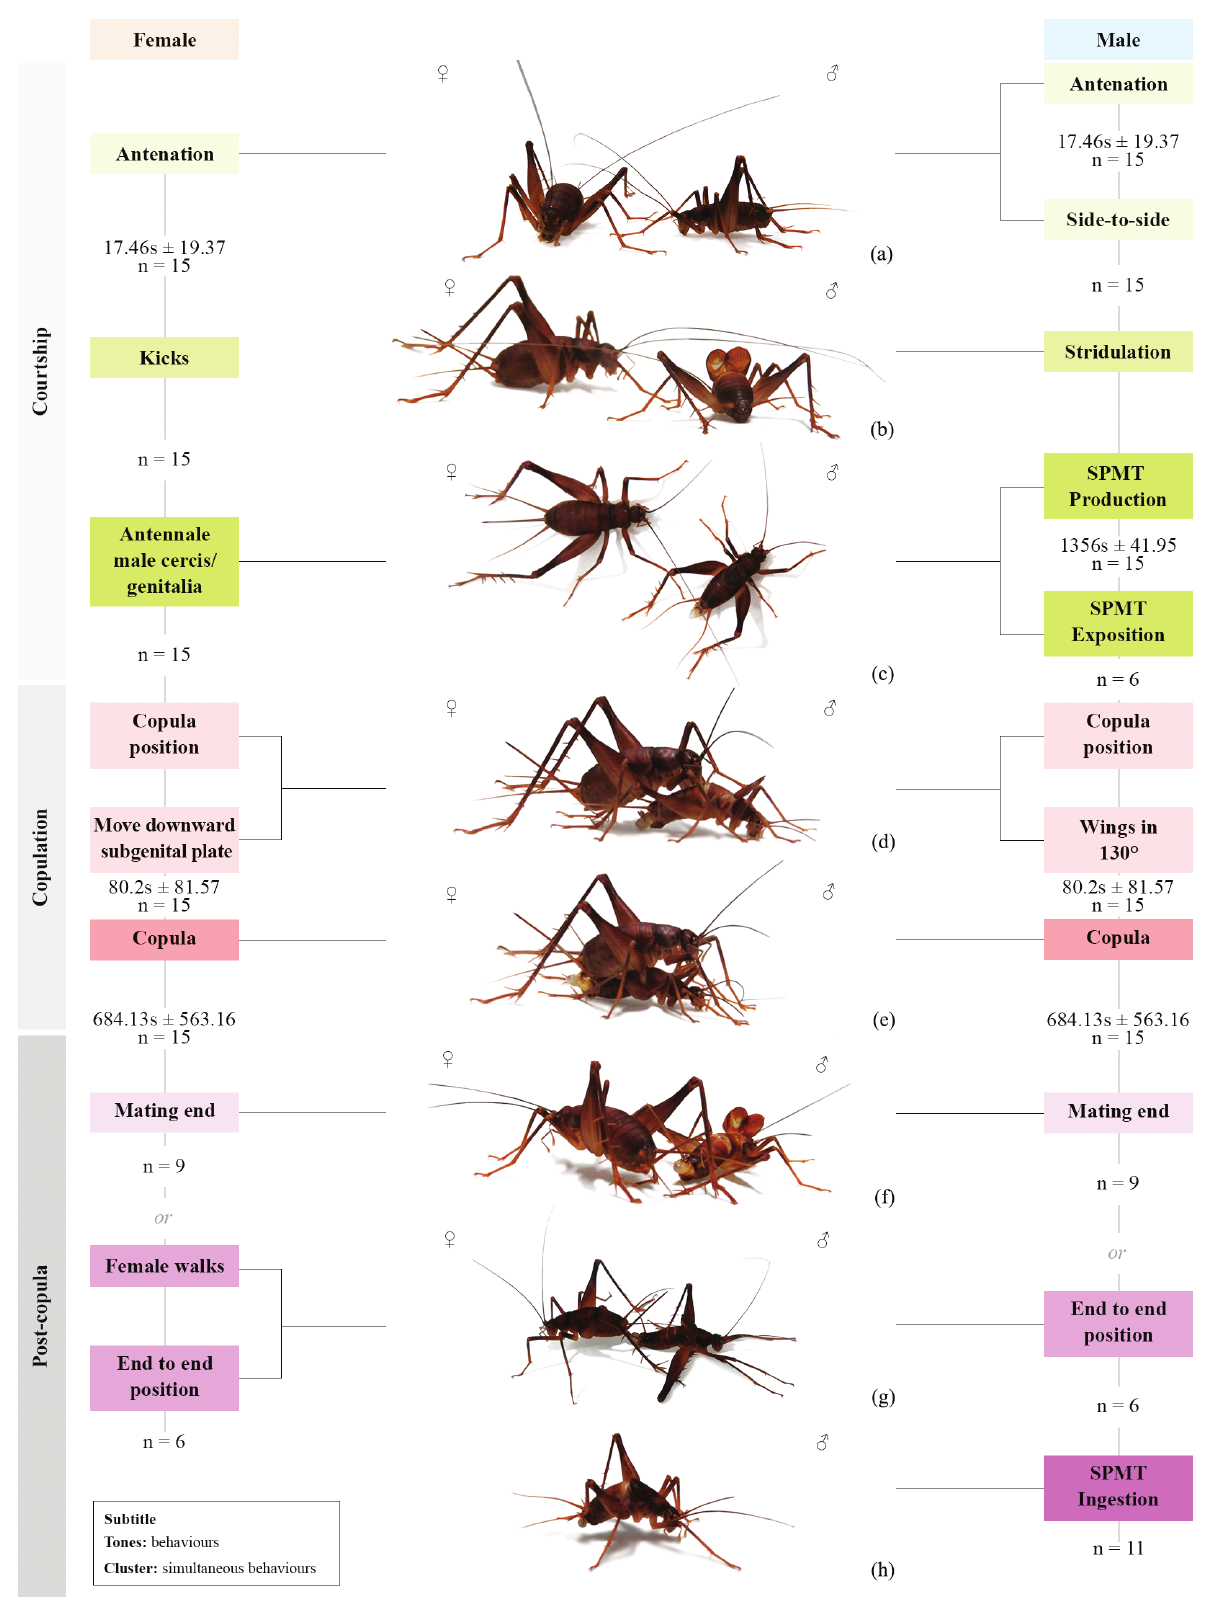
Fig. 2. Endecous chape mating behavior. A . Courtship position; B . Male stridulating next to the female; C . Exposure of the spermato- phore; D . Copulation position; E . Copulation; F . End of copulation; G . Female dragging the male in end-to-end position; H . Male removing the